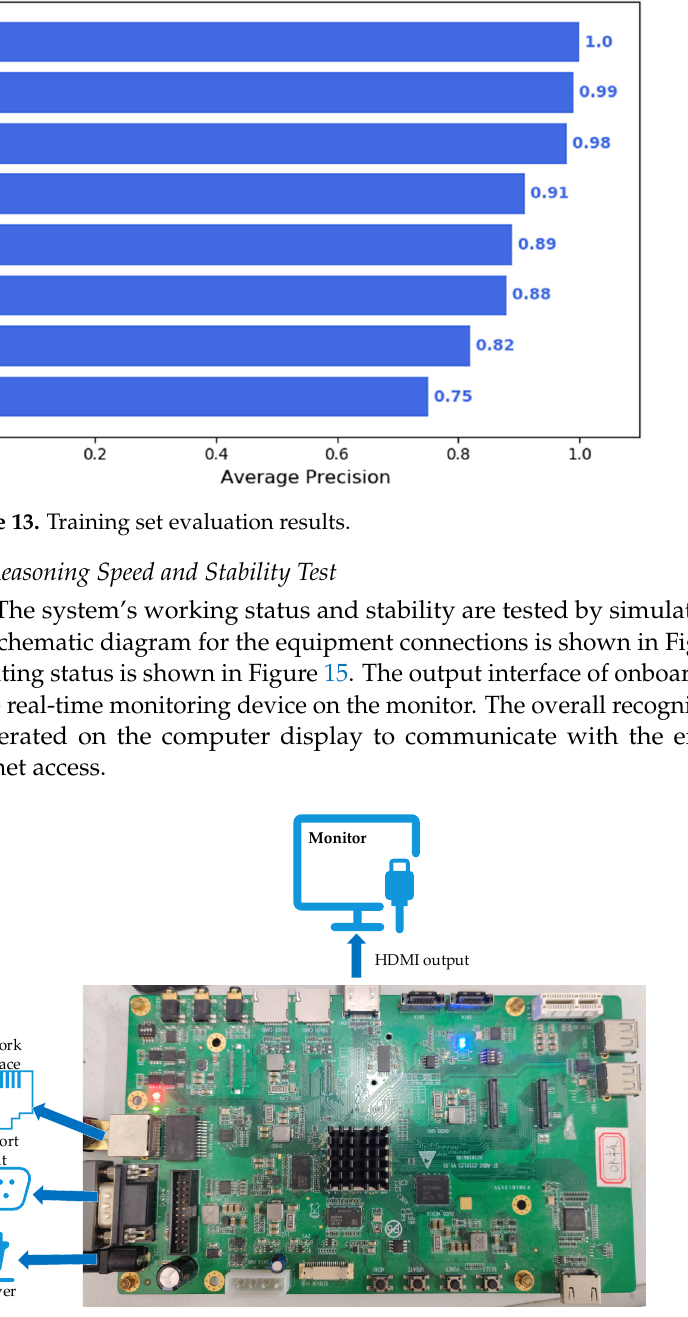
Figure 14. Connection diagram of testing platform .